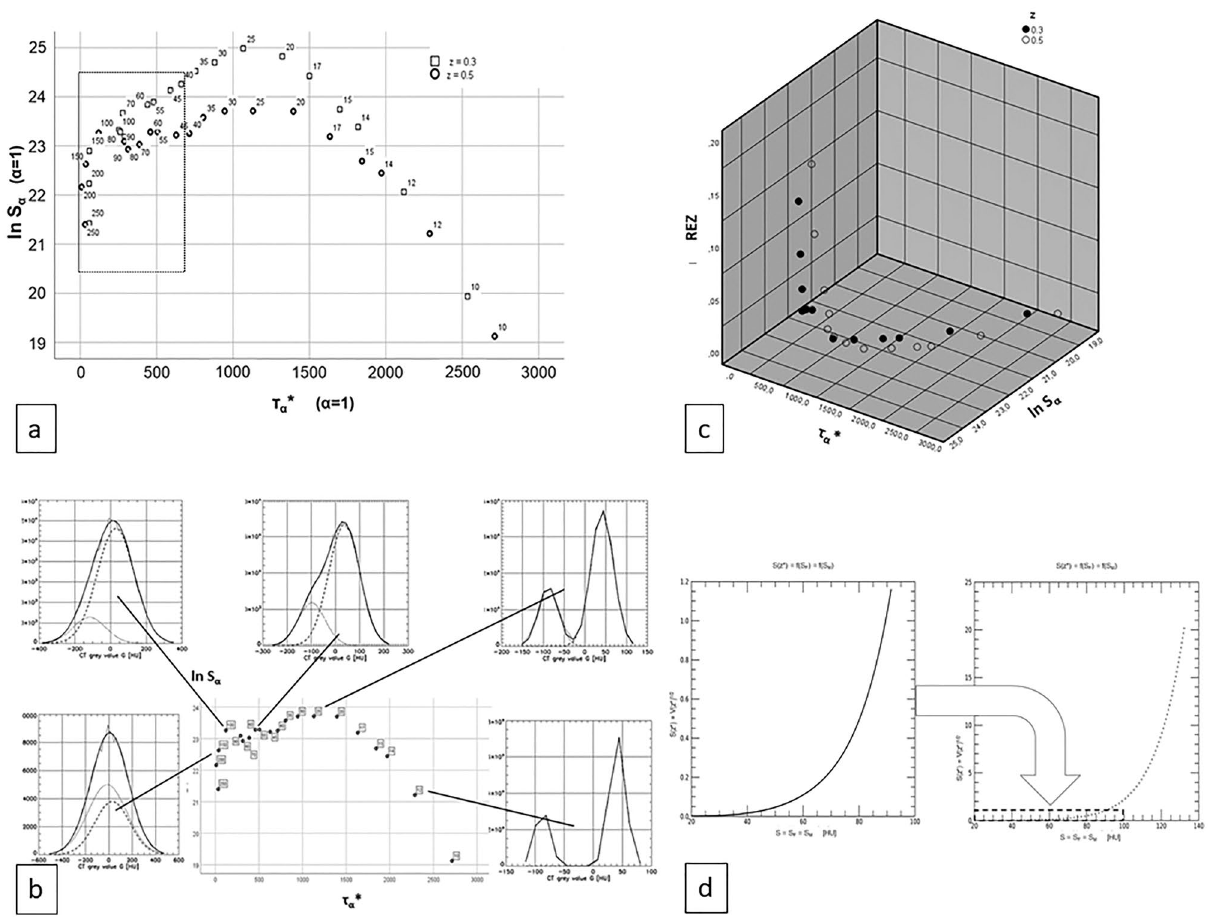
Figure 4. ( a ) Scatterplot for the variables FM separability τ α * and logarithm of weighted least squares sum ln S α of the Monte Carlo images Y A,r and Y B,r with r = 1, … , 20 (where A: z = 0.3 and B: z = 0.5). The data-points are labelled with the number of their grey-scale value histograms true standard deviations S + = S F + = S M + . The dashed rectangle on the left side marks the τ α * − ln S α —area of the diagram in Fig. 2d. ( b ) In the middle: Scatterplot for the variables FM separability τ α * and logarithm of weighted least squares sum ln S α of the Monte Carlo images Y A,r with r = 1, … , 20. The data-dots are labelled with the value of their grey-scale value histograms true standard deviations S + = S F + = S M + . Encircling the central scatterplot five empirical and estimated grey-scale value histograms X (thin, drawn), X(Θ) (fat, drawn), X F (Θ) (fat, dashed), X M (Θ) (fat, dotted) are presented, each is connected to its corresponding data-dot in the central scatterplot by a fat drawn pointer-line. ( c ) 3-D scatterplot of the variables FM separability estimator τ α *, the logarithm of the weighted least squares distance ln S α and relative error RE z of the z-estimator for the image-series Y A,r and Y B,r with r = 1, … , R. Black bubbles : A: z = 0.3 void bubbles: B: z = 0.5. Images Y A,r and Y B,r were excluded if S ≤ 5 or S ≥ 100 as well as if RE Z ≥ 0.2. The weighting exponent was set to α = 1. ( d ) Computed diagrams of the z-estimator’s standard deviation S(z*) as a function of the standard deviations S = S F = S M of the partial fat and muscle distributions in the scenario Y A and Y B with E F = −80 HU, E M = 50 HU, z = 0 and ranges 20 HU ≤ S ≤ 90 HU (A: left) and 20 HU ≤ S ≤ 130 HU (B: right). Note the different ranges on the ordinate. The graphs were generated with a true fat ratio value z + = 0.3. However the choice of the true fat ratio value z + had virtually no influence on the result when it was changed from z + = 0.3 to z + = 0.5. The weight exponent was chosen α = 0 which means z* is an LS-estimator rather